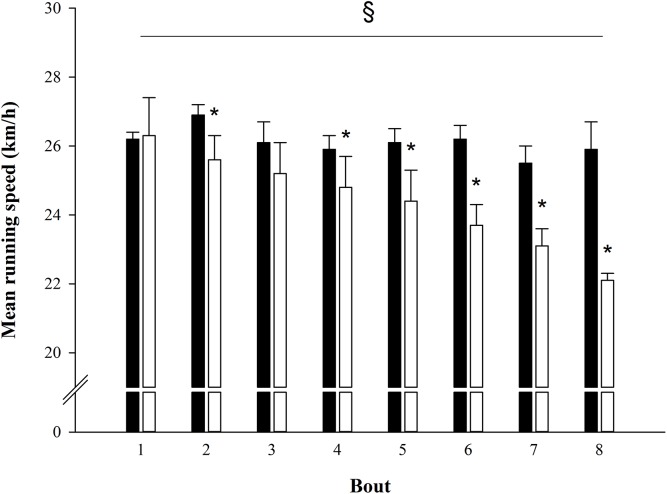
Mean running speed within 8 bouts of either a SEP (black bars) or a SEM (white bars) training session.* Significantly different from SEP (p < 0.05). § Significant “group x bout” interaction (p < 0.05)